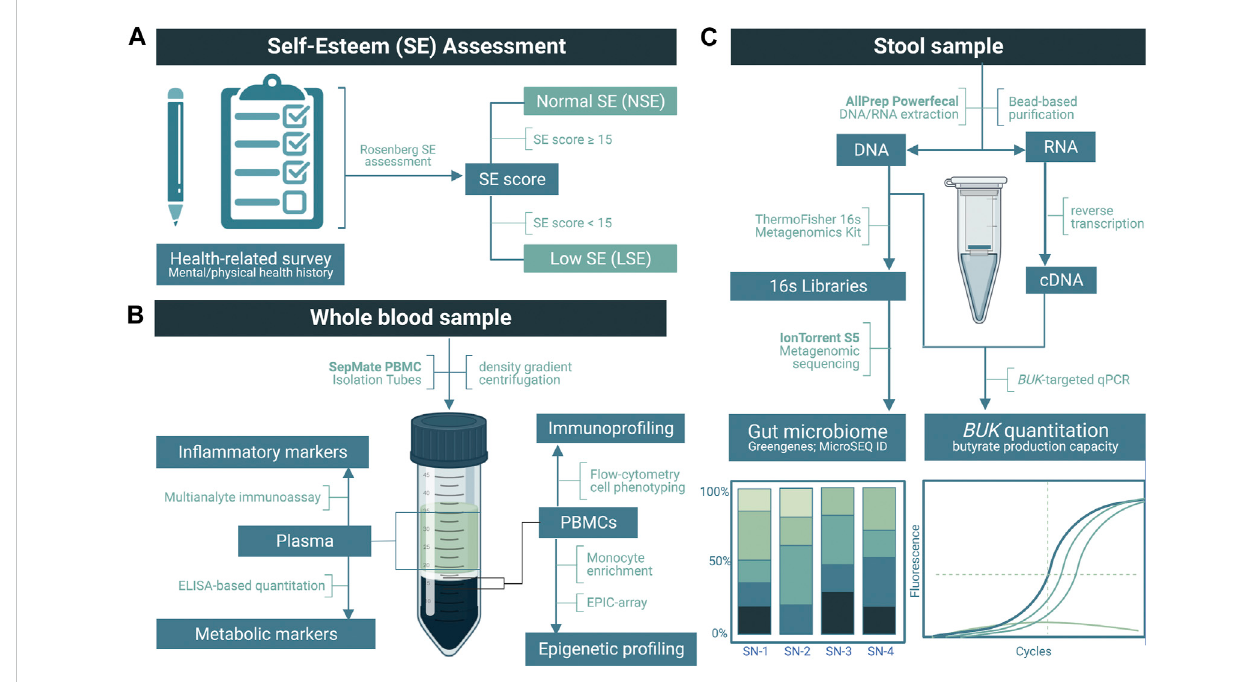
FIGURE 1 Overviewofthemethodologyusedinthisstudy. (A) Applicationofamodi fi edRosenbergself-esteem(SE)assessmenttocategorizelowSE(LSE)and normal SE (NSE) groups. (B) Upon the separation of the plasma, in fl ammatory and metabolic markers were quanti fi ed by multianalyte immunoassay and enzyme-linked immunosorbent assay (ELISA), respectively. From the peripheral blood mononuclear cells (PBMCs), fl ow cytometry was performed for immunopro fi ling, followed by monocyte enrichment and an EPIC array for epigenetic pro fi ling. (C) Following nucleic acid puri fi cation from stool samples, DNA was used to quantify the relative abundance of gut bacteria via metagenomic sequencing and butyrate-kinase (BUK) gene copies via